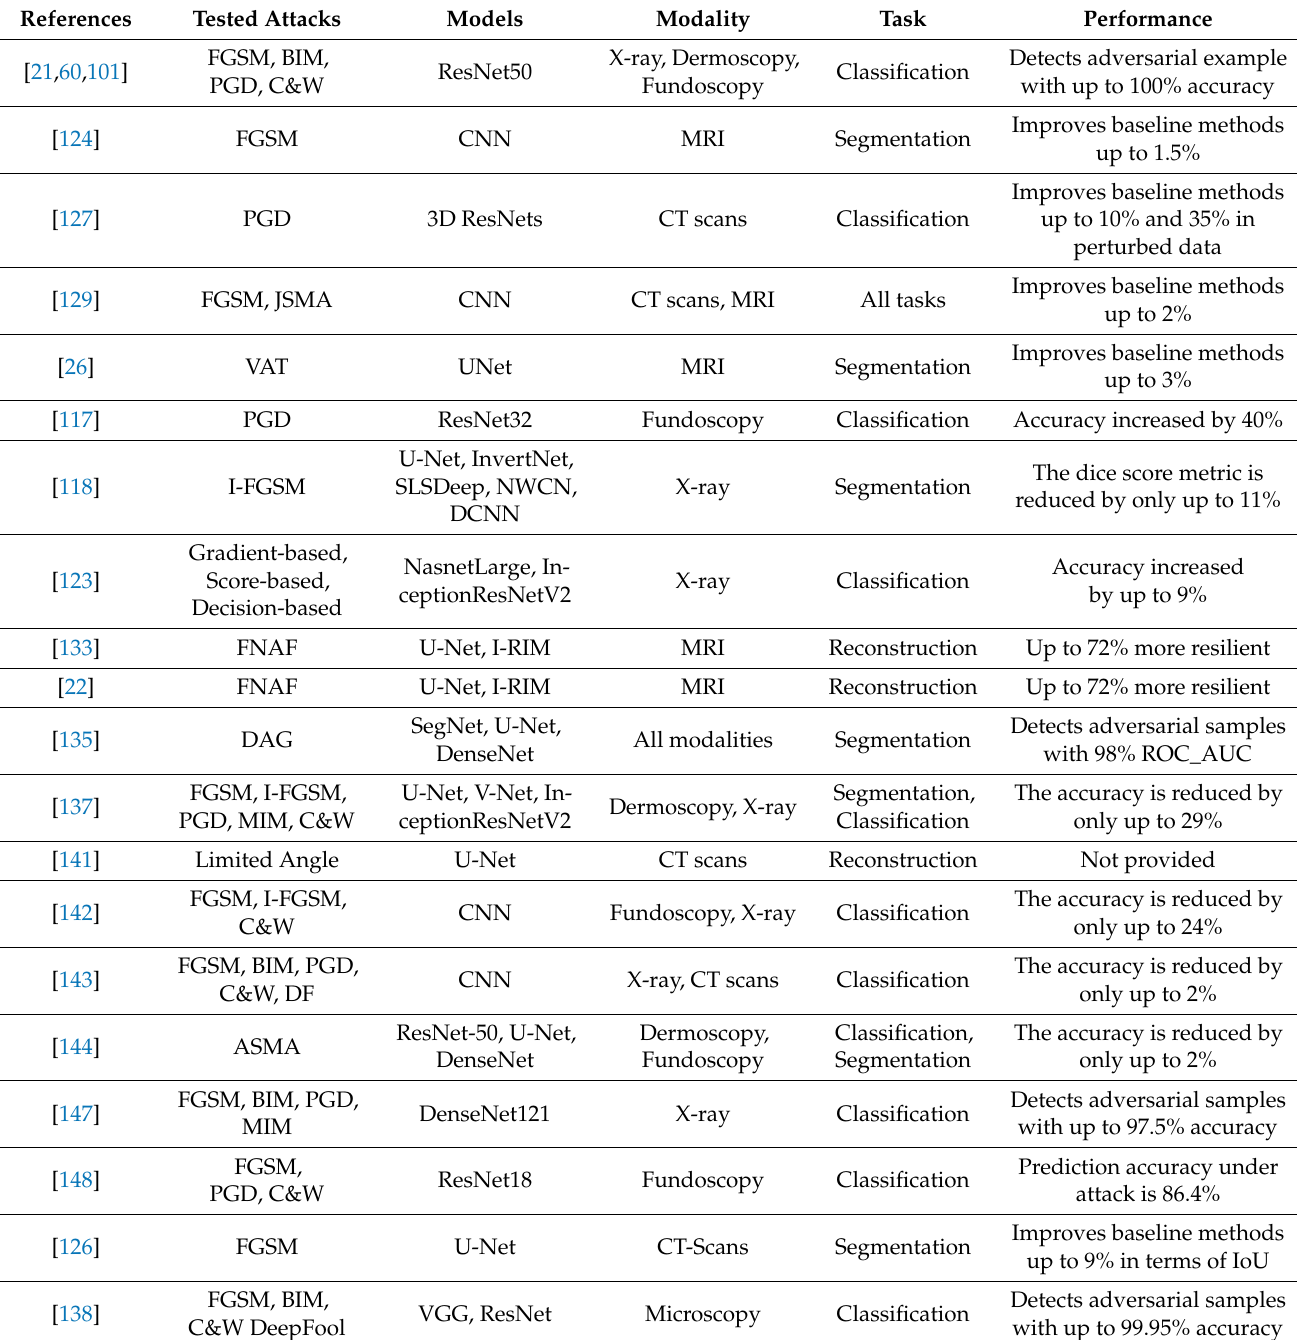
Table 3 summarizes all the defense and attack detection methods with the correspond- ing tasks, modalities and models. We observe that some methods provide significant protection against attacks while others simply reduce the success rate of an attack. At the same time, attack detection methods, detect adversarial samples with very high accu- racy. For example, the studies [60,101] detect adversarial samples in several images and implemented in medical adversarial samples in [21]. Table 3. Overview of defense and attack detection